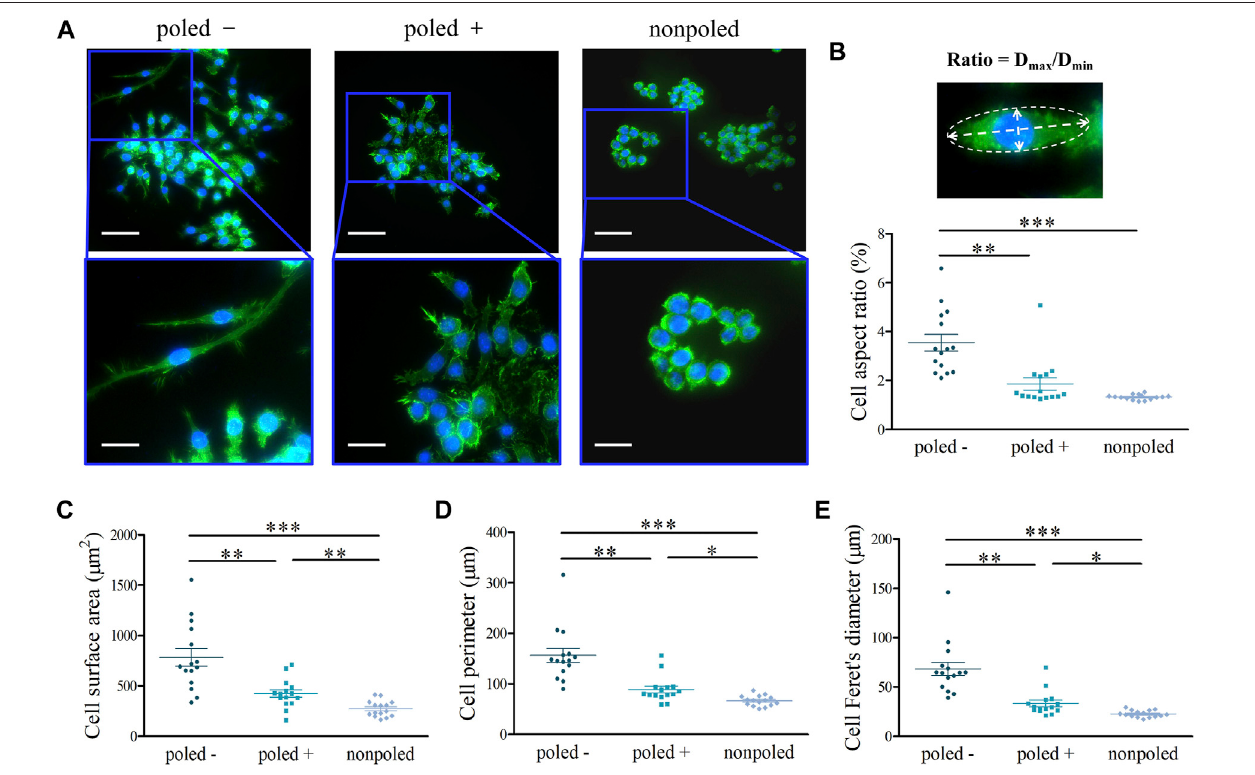
FIGURE 5 | Macrophage morphology and elongation. (A) Representative fl uorescence images of the morphology of RAW 264.7 macrophages after the nucleus (blue) and cytoskeleton (green) staining (top scale bar: 50 μ m, bottom scale bar: 25 μ m). (B) Cell diameter aspect ratio (D max /D min ) obtained by the cell morphology analysis, and the fl uorescence images simply illustrating the cell-diameter measurement. Quantitative analysis of (C) cell surface area, (D) cell perimeter and (E) Feret ’ s diameter. * p < 0.05; ** p < 0.01; *** p < 0.001.